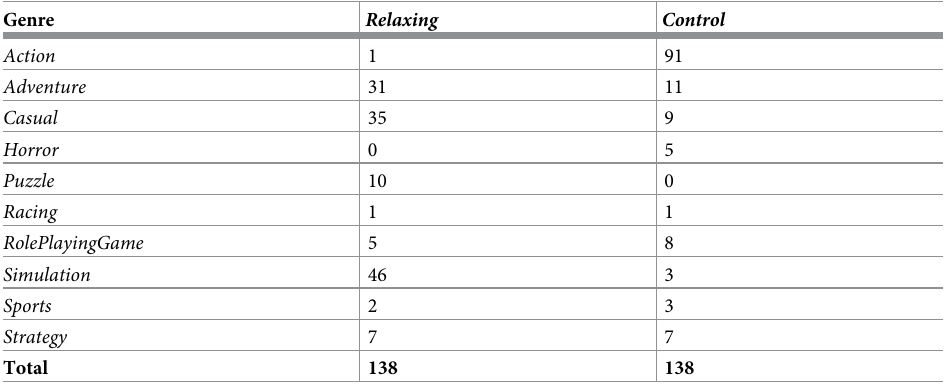
Table 2. Genres of games for the relaxing group and the matched control